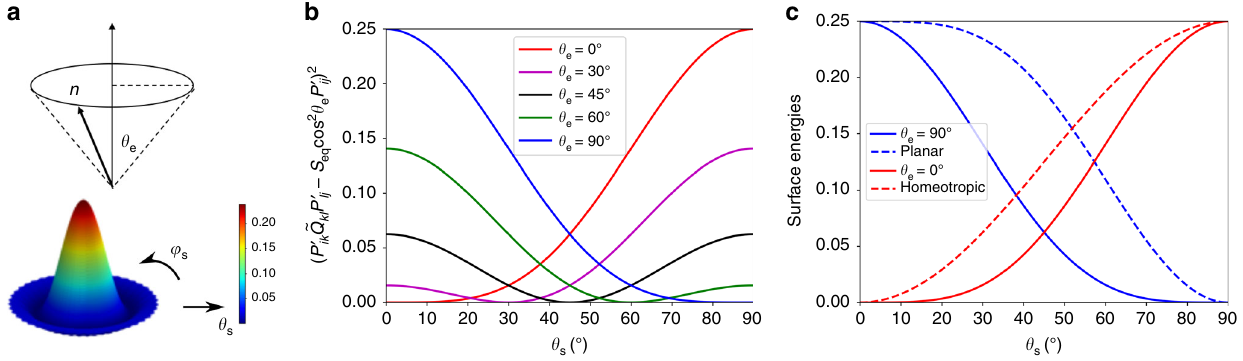
Fig. 5 Degenerate Conic anchoring. a Schematic representation of degenerate conic anchoring with preferred tilt conic angle θ e . b The value of (cid:2) (cid:3) 2 ~ Q P ′ P ′ (cid:2) S P ′ 2 θ as a function θ s and ϕ s when θ e = 60°, which illustrates the degenerate conic anchoring with degeneracy in the azimuthal kl ij ik lj eq cos e